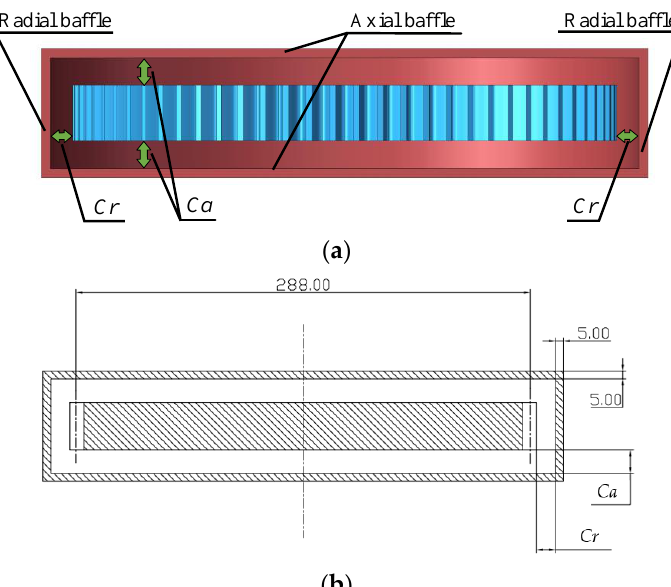
Figure 2. Axial clearance and radial clearance: ( a ) Three-dimensional model; ( b ) Engineering drawing.